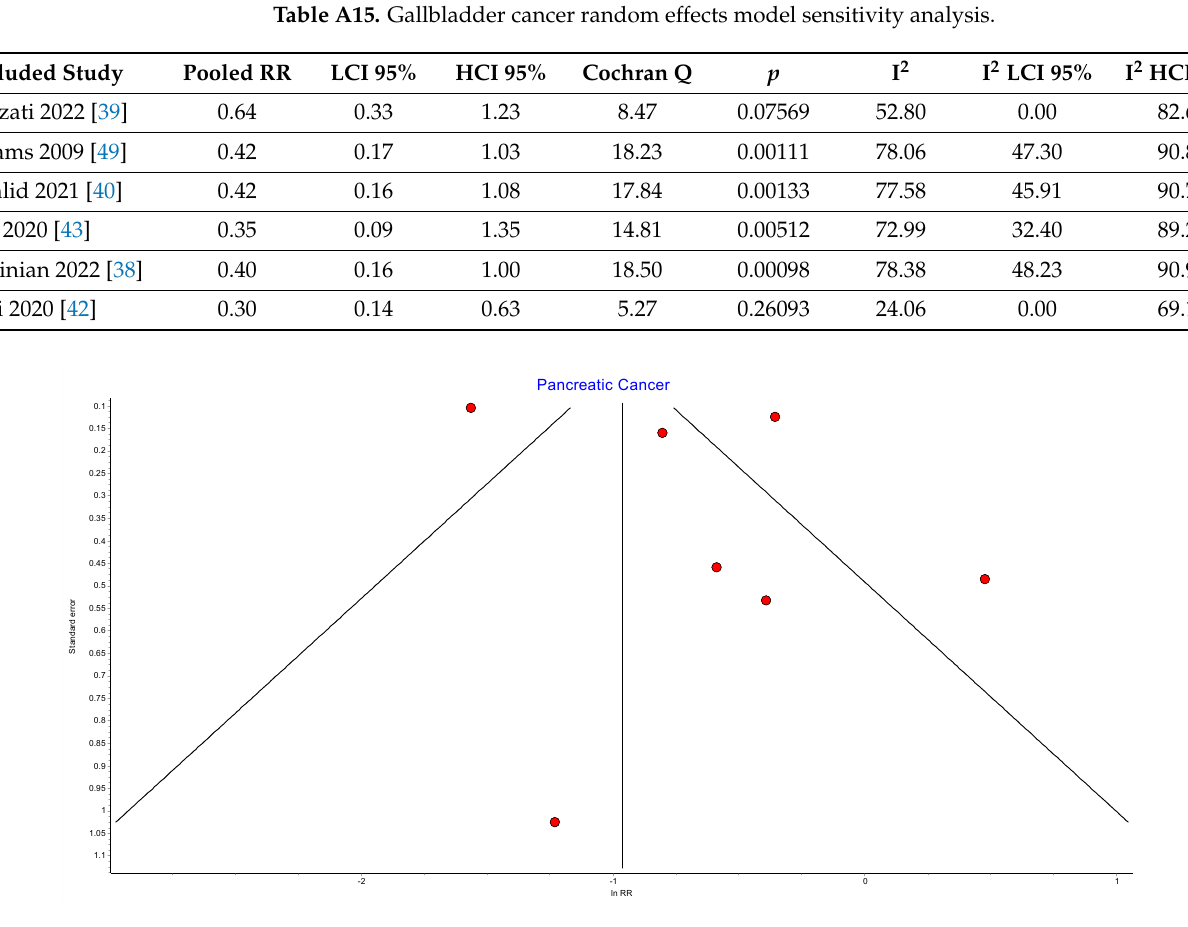
Figure A16. Pancreatic cancer random effects model funnel plot.